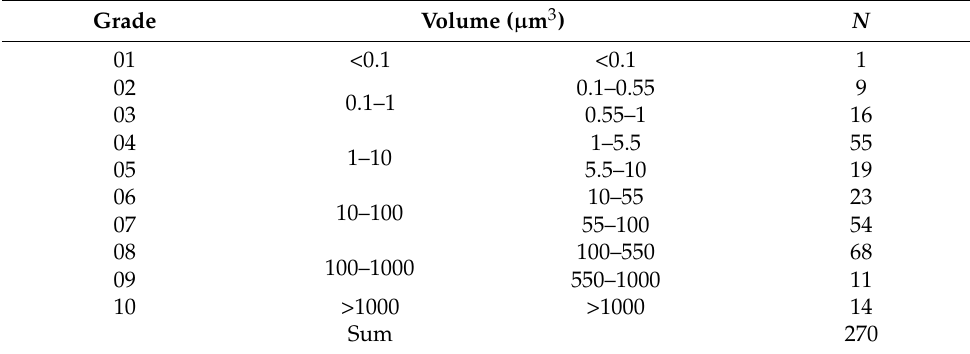
Table 3. Volume classification